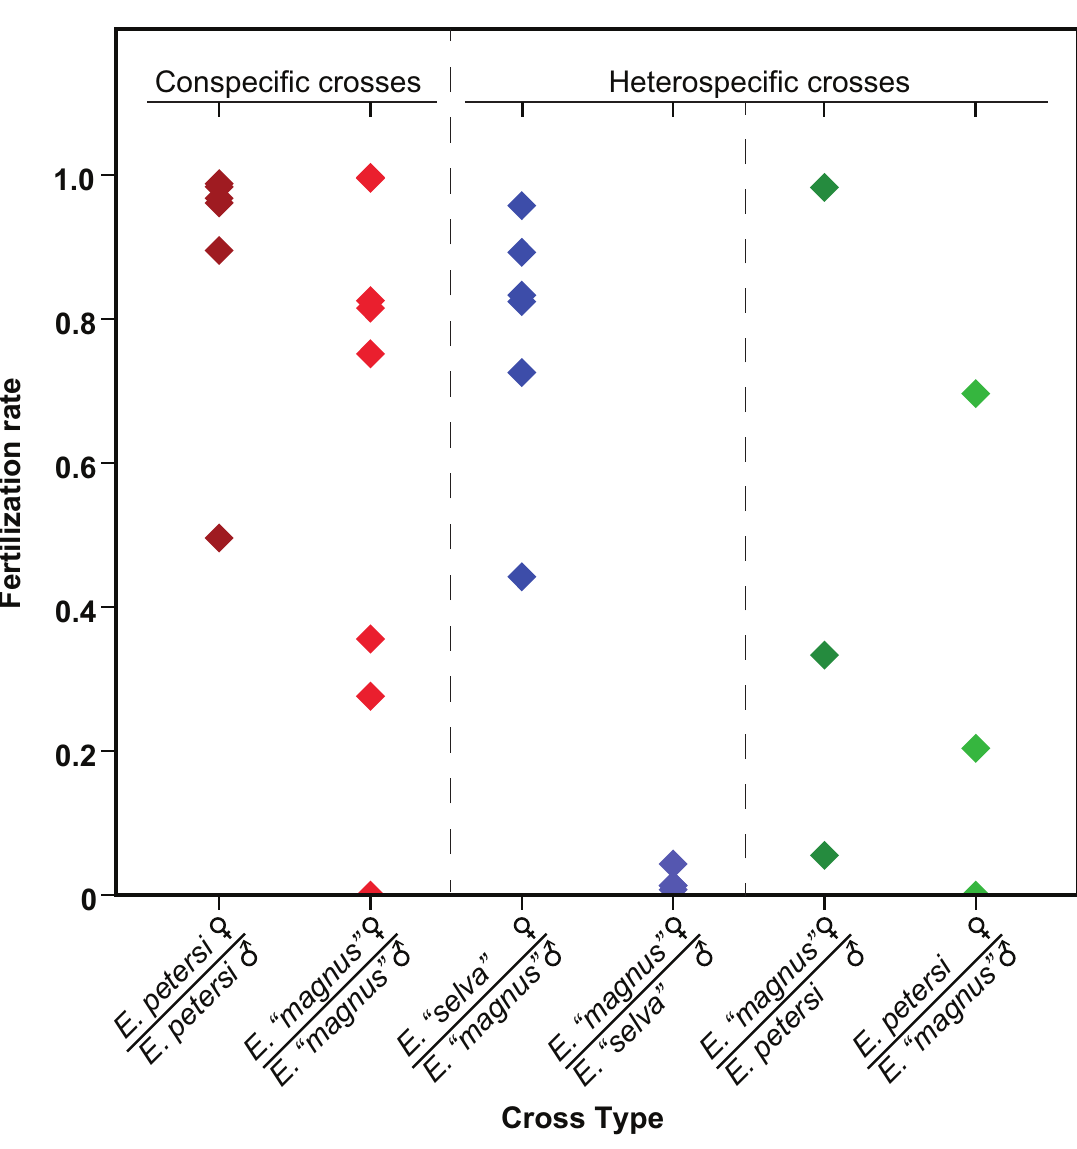
Fig 3. Fertilization rates for conspecific and heterospecific crosses. Overall fertilizationrates decreased in heterospecific crosses compared to conspecificcrosses but this was due to significantreductions in only some of the heterospecific cross